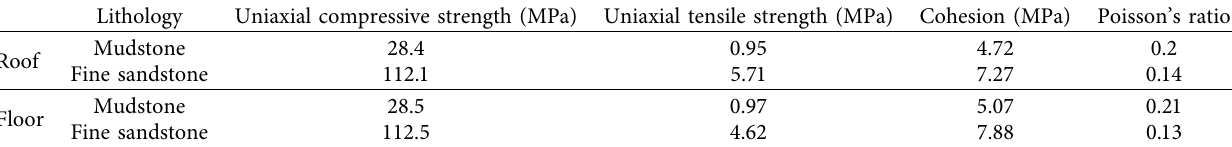
Table 1: Mechanical properties of rock.